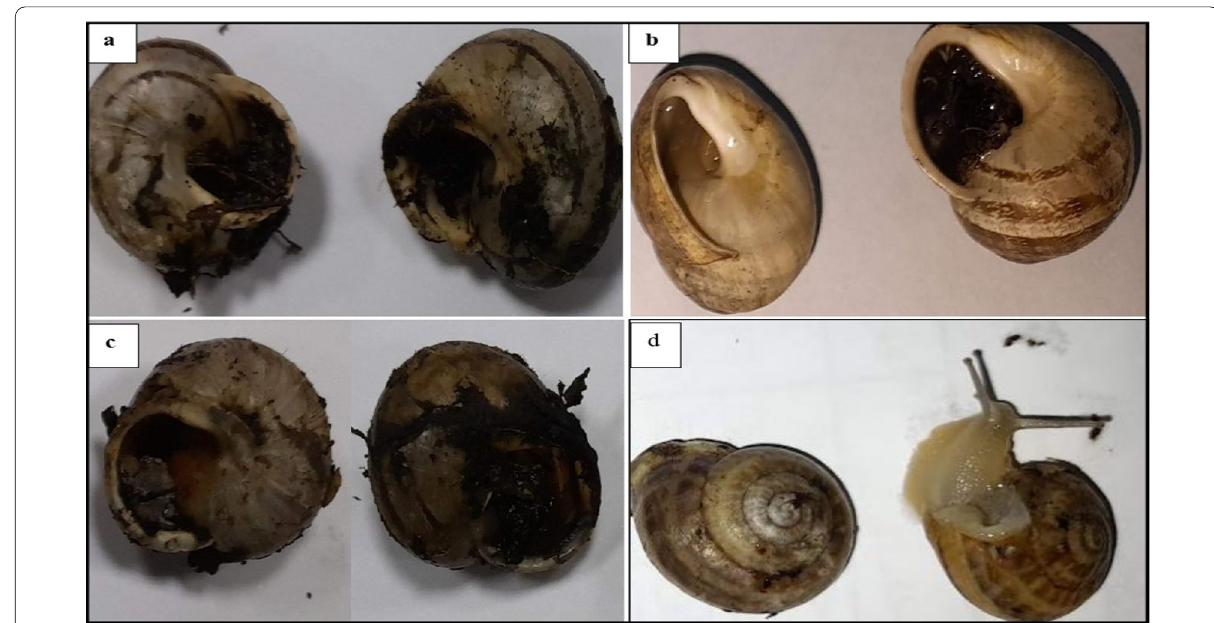
Fig. 6 Effect of chlorfenapyr ( a ), imidacloprid ( b ) and indoxacarb ( c ) on the adults of M. vermiculata compared with the control ( d